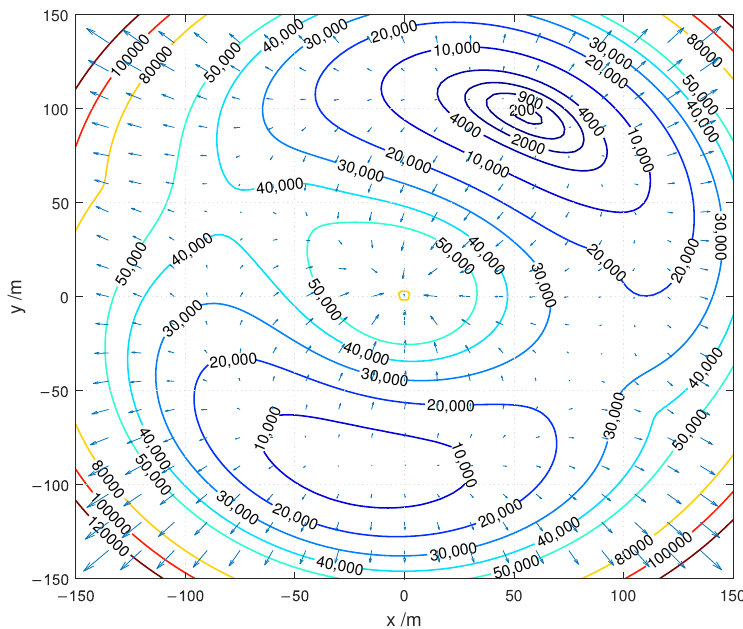
Figure 2. The contour plot of the considered ML objective function J ML ( x )